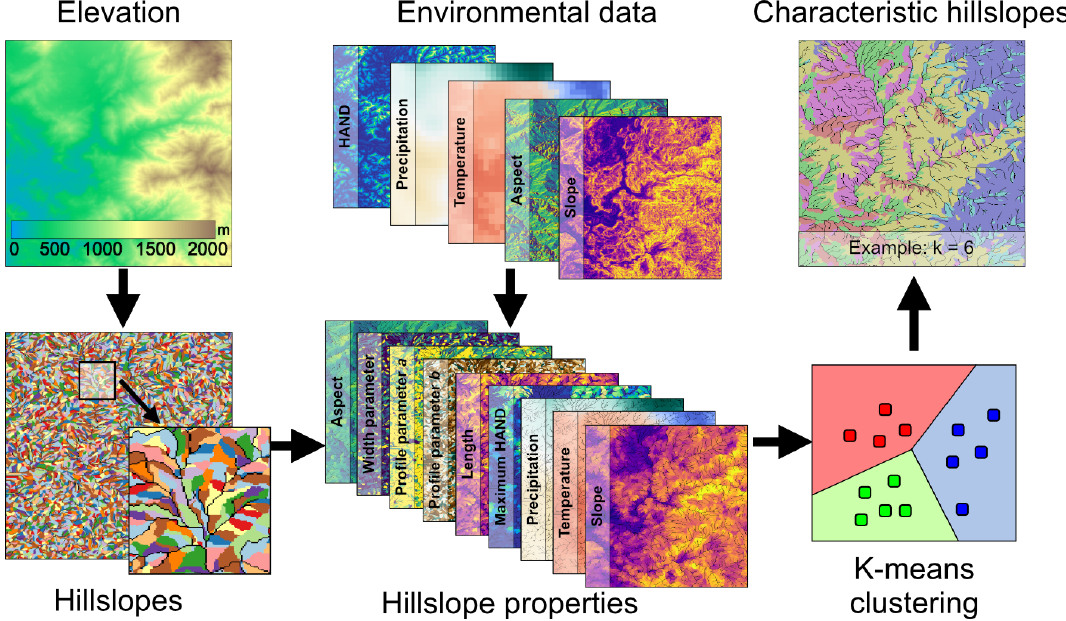
Figure 3. The characteristic hillslopes are defined by (1) delineating the hillslopes from the elevation data, (2) calculating a suite of prop- erties for each hillslope from environmental data, and (3) using the hillslope properties and the k -means clustering algorithm to define k characteristic